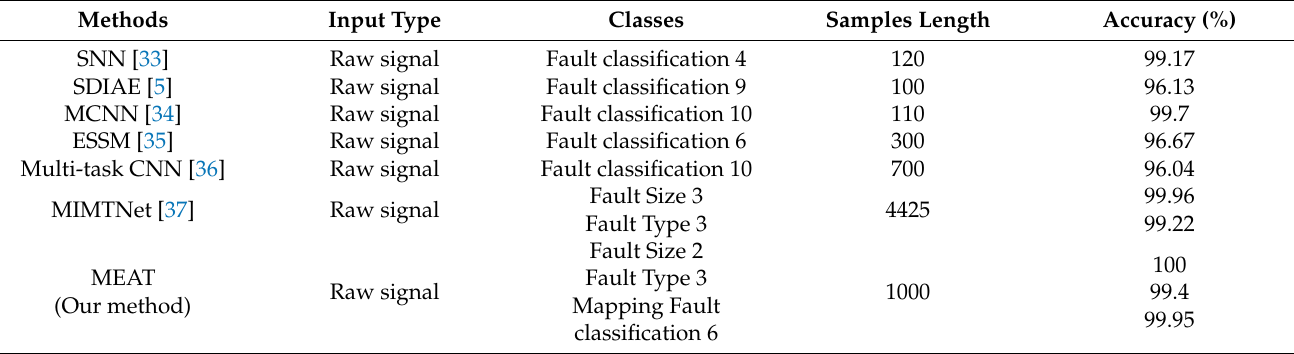
Table 8. Comparative analysis of CWRU